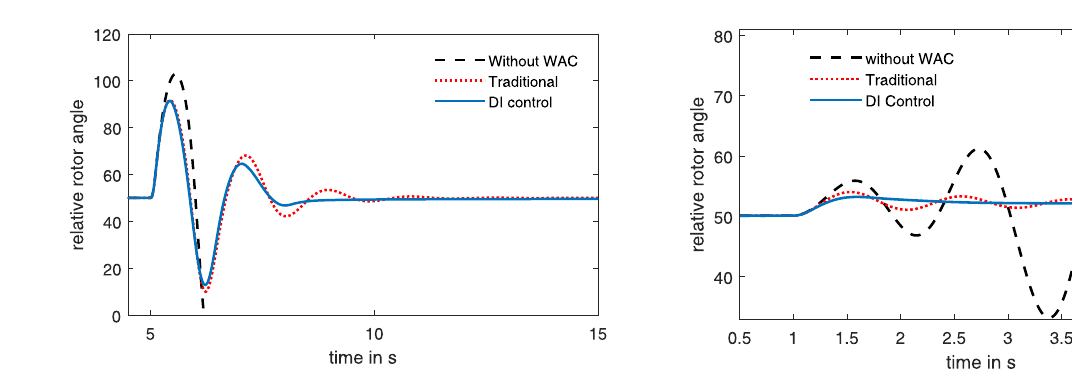
Fig. 10 Relative rotor angle for load disturbance